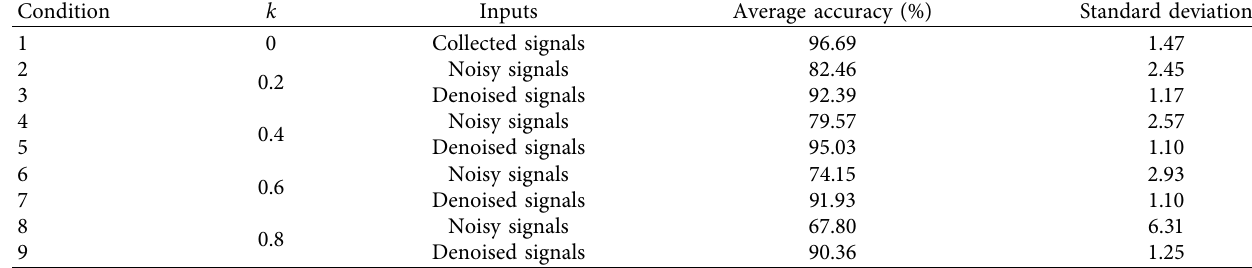
Table 4: Average accuracy and standard deviation of each condition.